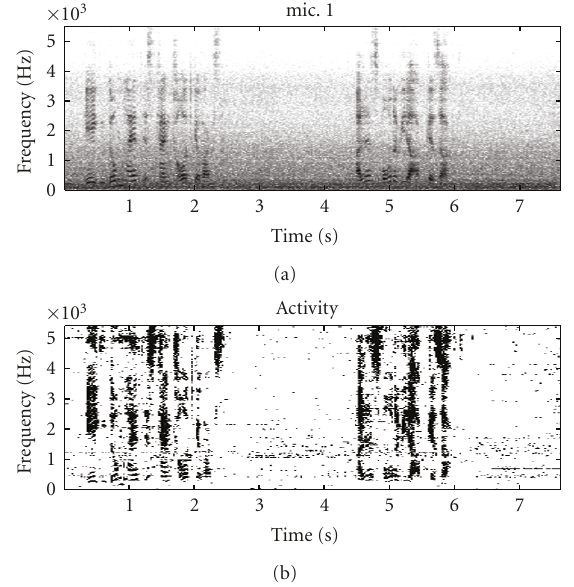
Figure 6: Spectrogram of the microphone input (mic. 1 at car speed of 140 km/h, short speaker). The lower figure depicts the results of the voice activity detection (black representing estimated speech activity) with T = 1 . 2 and q = 0 . 5.